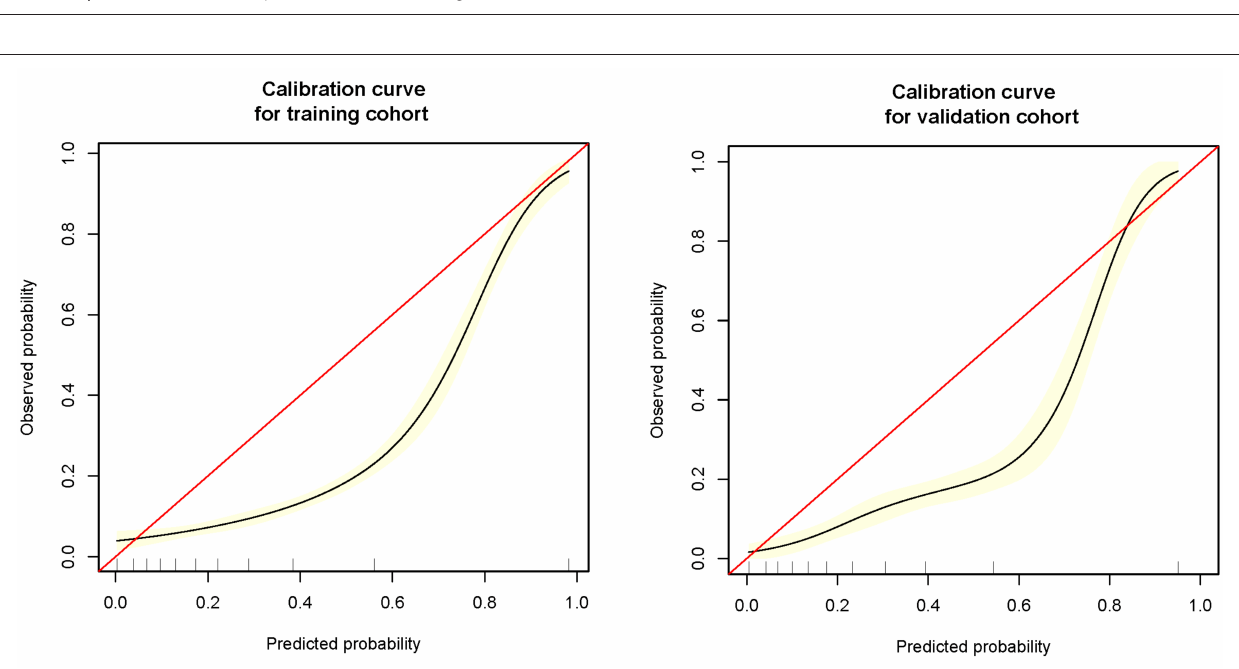
FIGURE 1 | The ROC curve of the predictive model in training cohort and validation cohort.